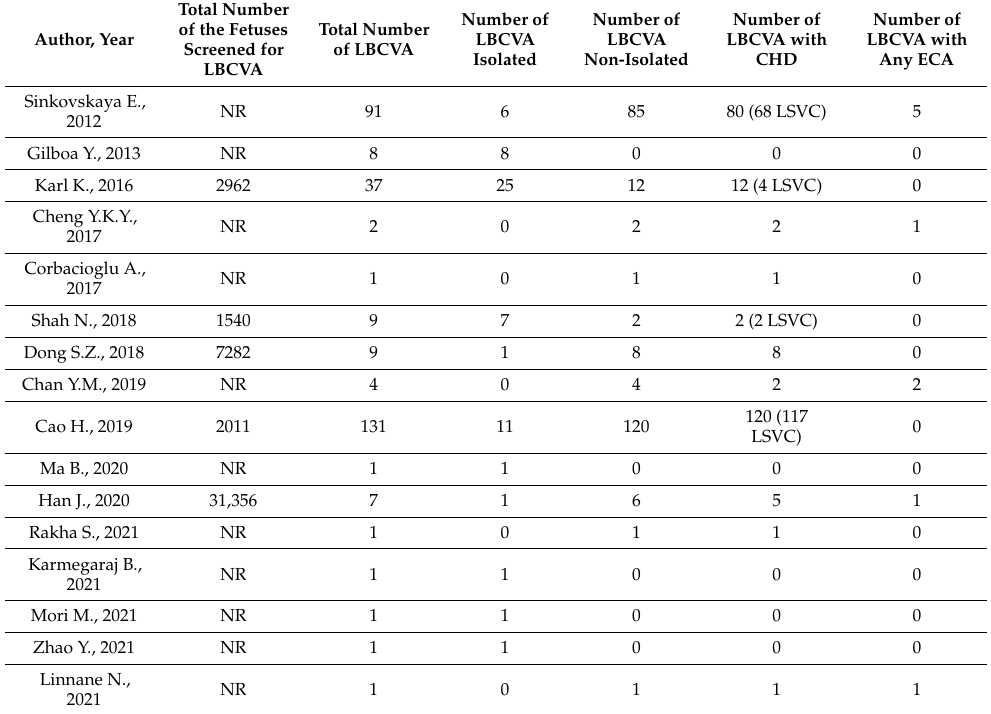
Table 3. Summary of proportions of prenatal diagnosis of left brachiocephalic vein anoma- lies